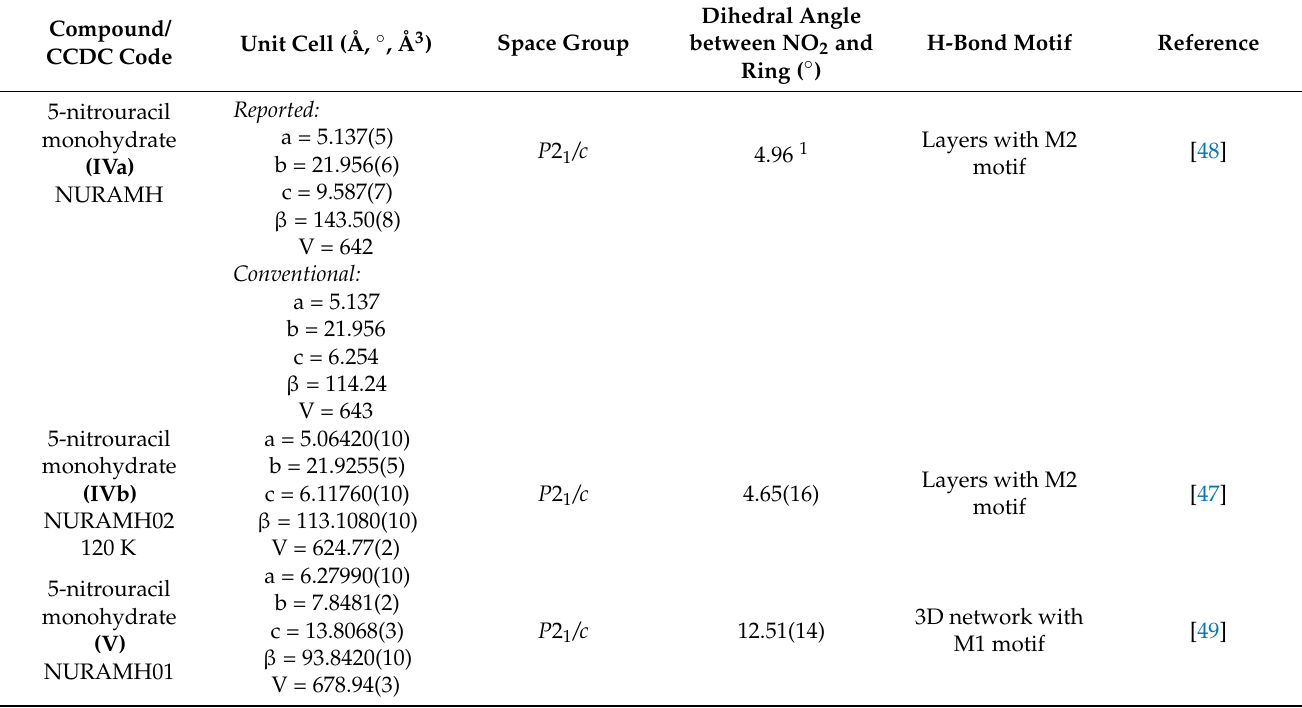
Table 3. Crystallographic data of 5NU monohydrates.